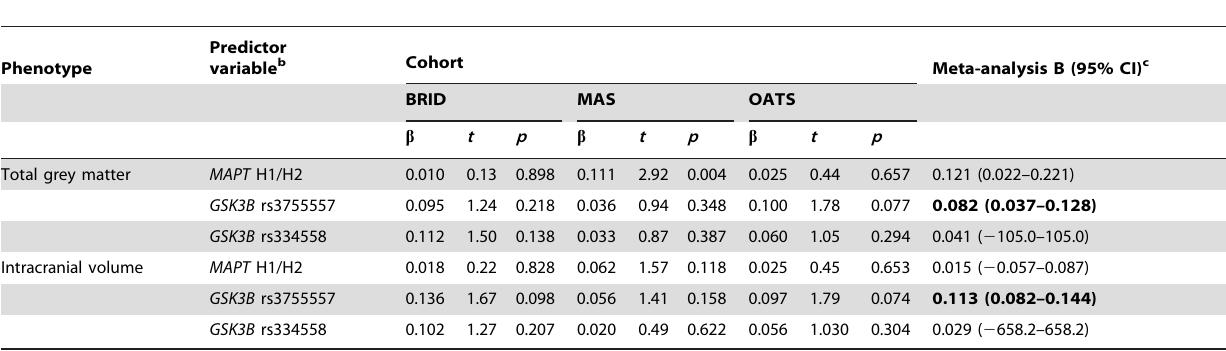
Table 2. Linear regression analyses to assess effect of MAPT diplotype and GSK3B genotypes on total grey matter and intracranial volume a .